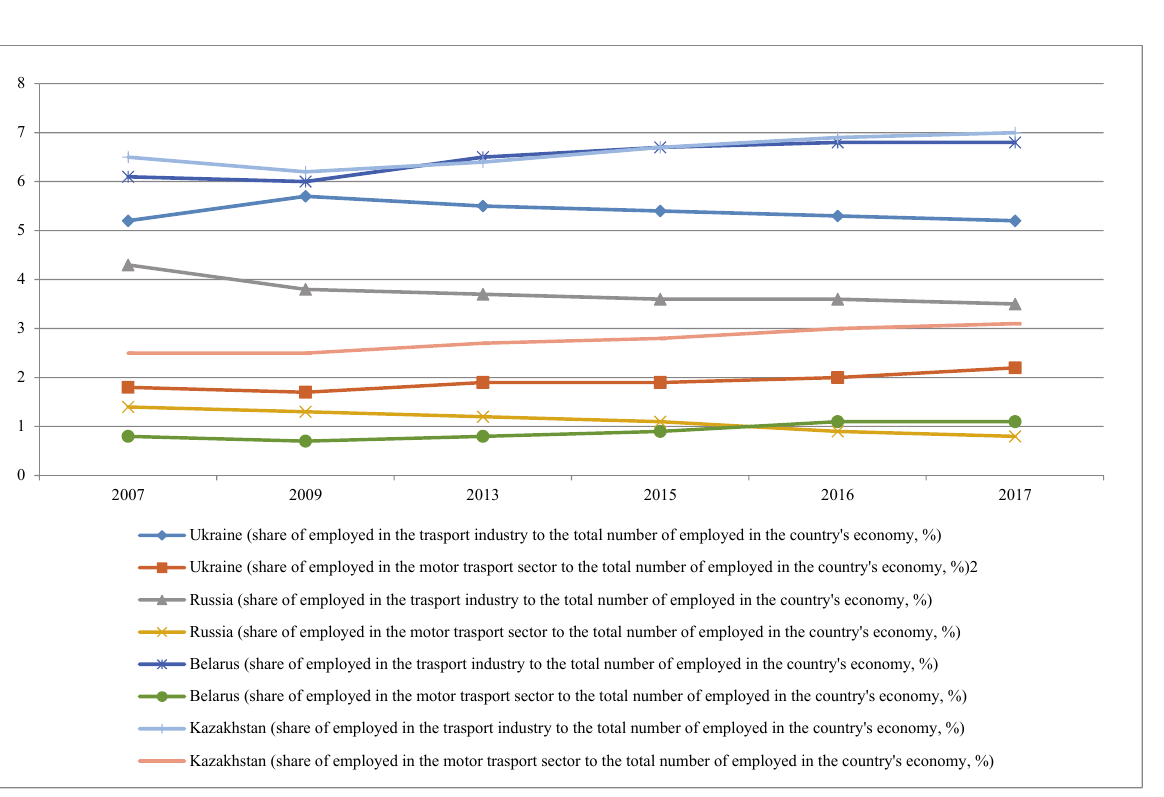
Fig. 3. Dynamics of the share of employed in the transport industry and its motor transport sector in the total number of employed in key countries of the post-Soviet economic space in 2007–2017 *- Compiled by the author on the basis of State Statistics Service of Ukraine (2019), Federal State Statistics Service of the Russian Federation (2019), National Statistical Committee of the Republic of Belarus (2019), Committee on Statistics of the Republic of Kazakhstan